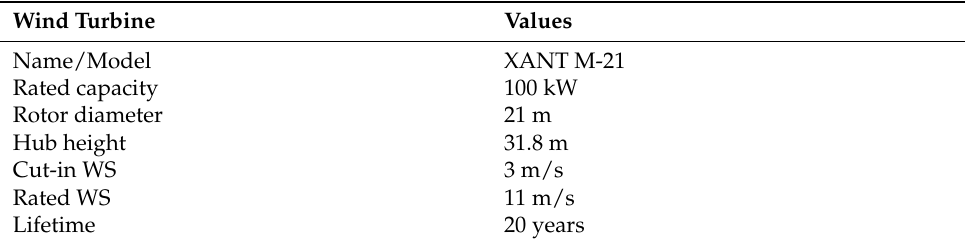
Table 8. Technical specification of the